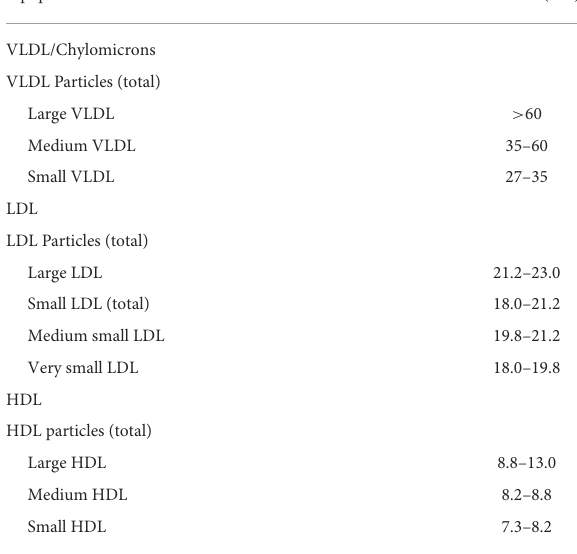
TABLE 1 Diameter range of lipoprotein